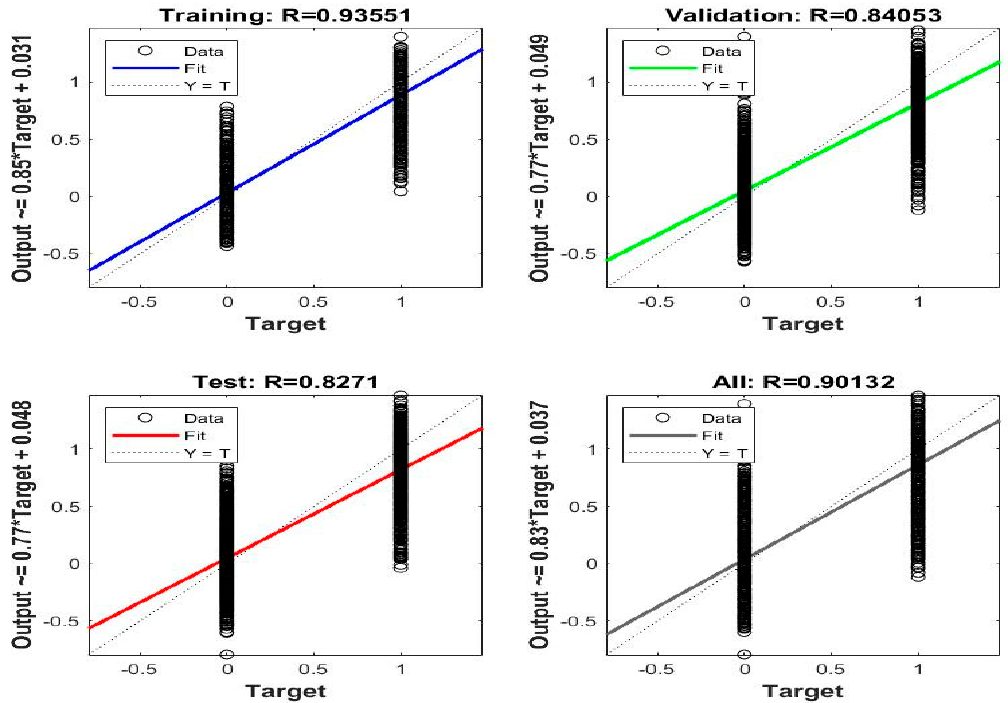
Figure 14. Displays the performance of FFNN through regression values for endoscopic image di-